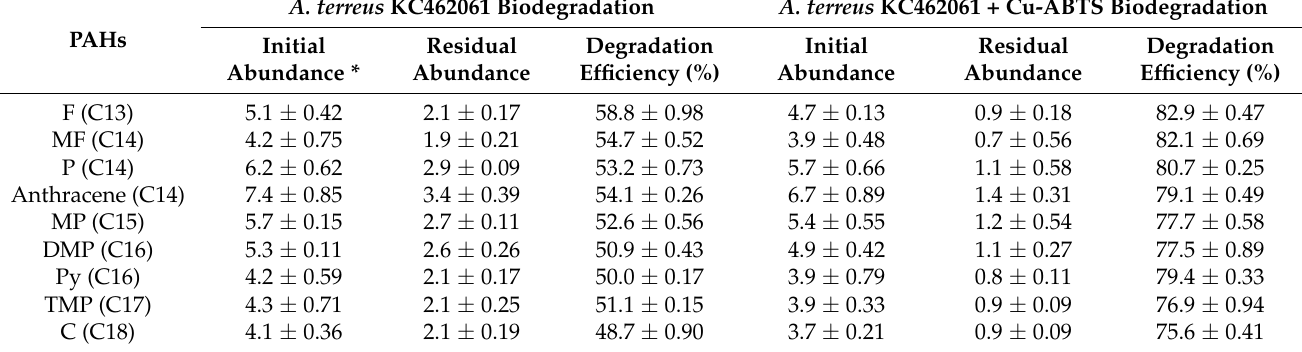
Table 3. Biodegradation efficiencies of A. terreus KC462061 and A. terreus KC462061 + Cu-ABTS for C13 to C18 PAHs after 10 days.